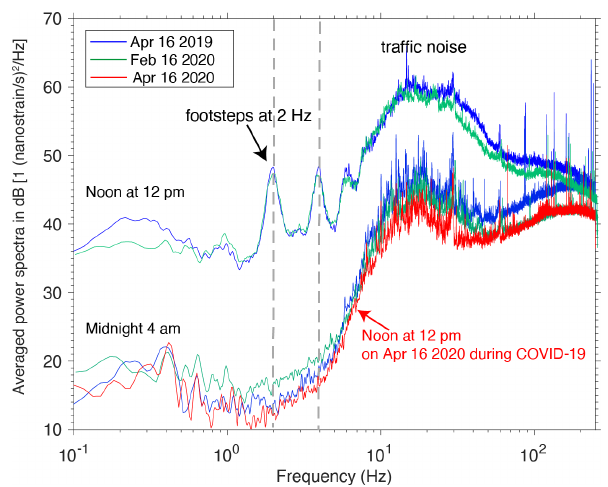
Figure 11. The power spectra density of 1min DAS data on three days (16 April 2019, 16 February 2020, and 16 April 2020) shows that signals at noon are much stronger than signals at 04:00UTC. Additionally there are distinct peaks that appear in the signals from midday, particularly strong at 2 and 4Hz. Traffic noises correspond to > 5Hz signals. During the COVID-19 pandemic the power spec- tra at noon are as low as at nighttime, and no footstep signals are